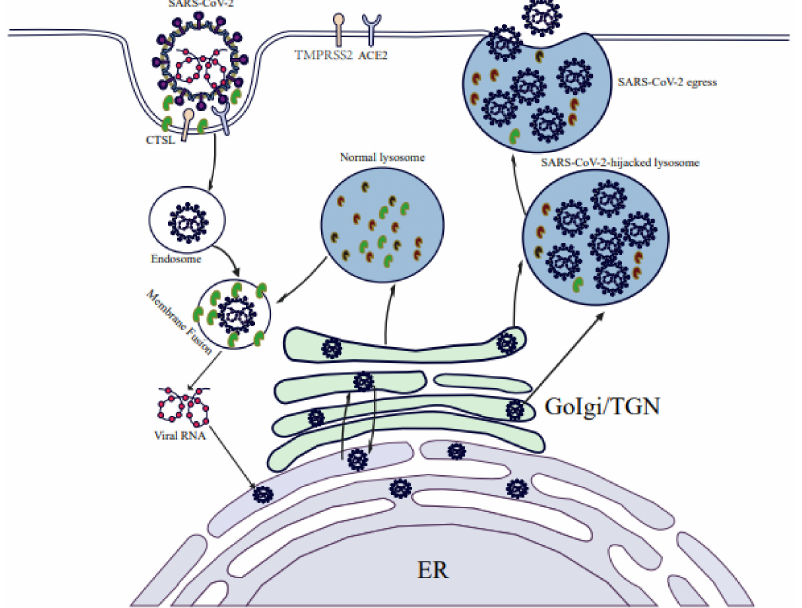
Figure 1. SARS-CoV-2 replication is dependent on a lysosome-based pathway. SARS-CoV-2 entry into the host cells is mediated by the endocytic pathway. The entry of SARS-CoV-2 and mature virus RNA release into the cytoplasm requires CTSL activity and an acid lysosomal environment. Progeny viruses exit cells by hijacking a lysosome-based